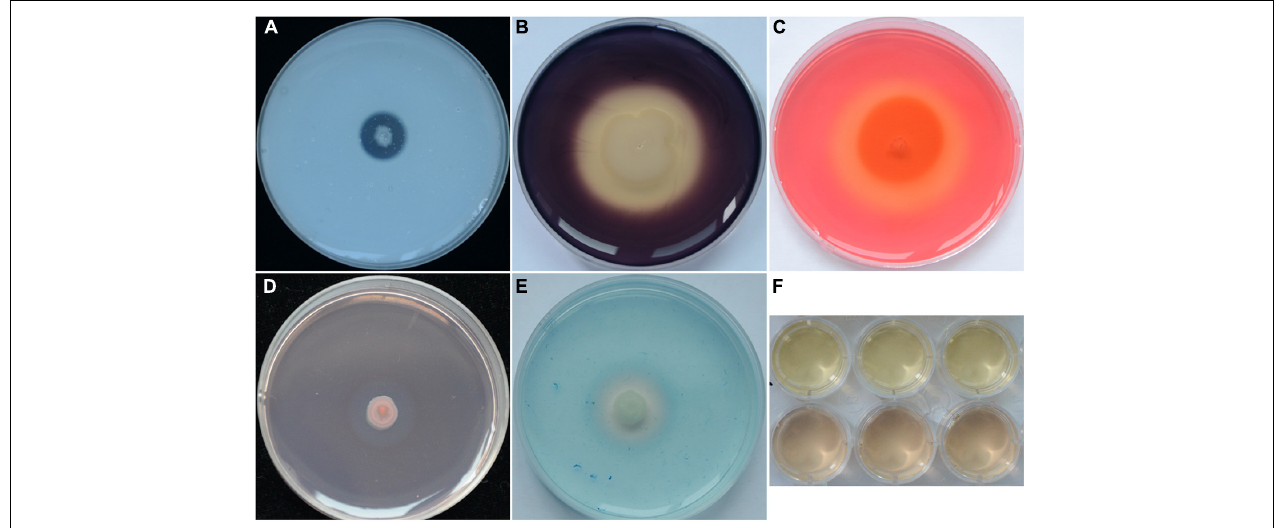
FIGURE 3 | Antifungal and PGP traits of strain YB-04. (A) Protease production; (B) amylase production; (C) cellulose production; (D) β -1,3-glucanase production; (E) siderophore production; (F) IAA production.